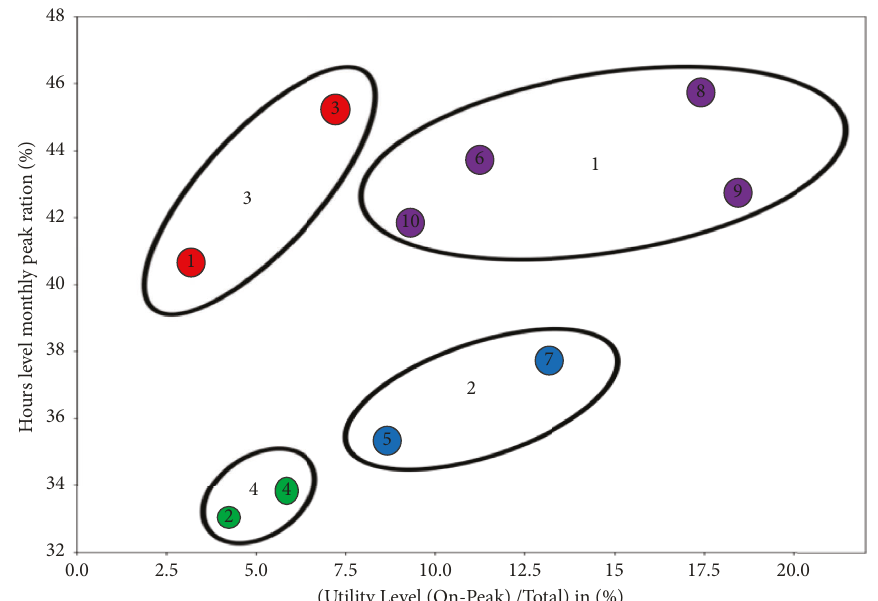
Figure 8: Customer classification based on monthly house-level and utility-level peak time consumption in a summer month.